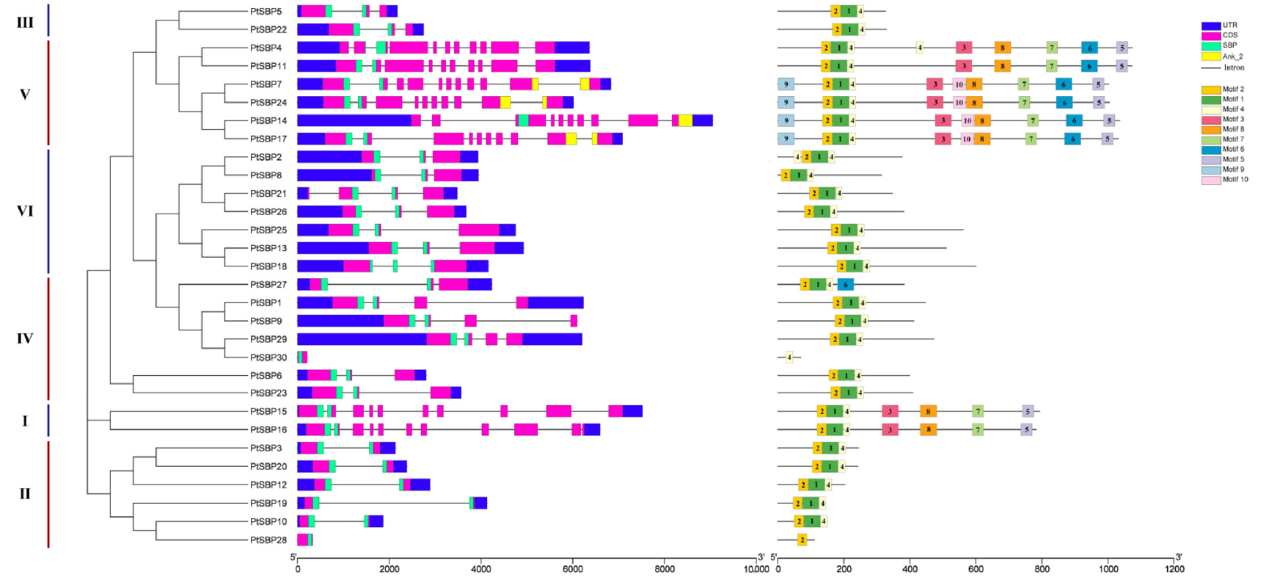
Figure 3. Phylogenetic tree, gene structure and conservative motif analysis of PtSBP. Phylogenetic trees were constructed based on 30 PtSBP proteins, which were divided into 5 groups. In the analysis of gene structure, blue represents UTR, pink represents CDS, green represents SBP region, yellow represents Ank_2 region, and “-” represents intron. The conservative motif of SBP gene is predicted by MEME method, and the numbers (1–10) in the colored rectangles indicate motif 1–10, and the length of the rectangle indicates the size of the motif.